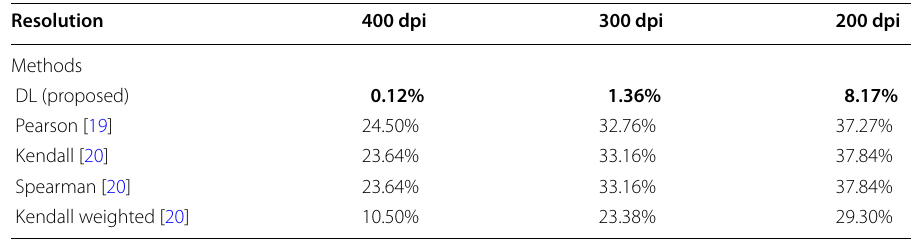
Table 3 Error probability of pattern recognition at low scan resolution